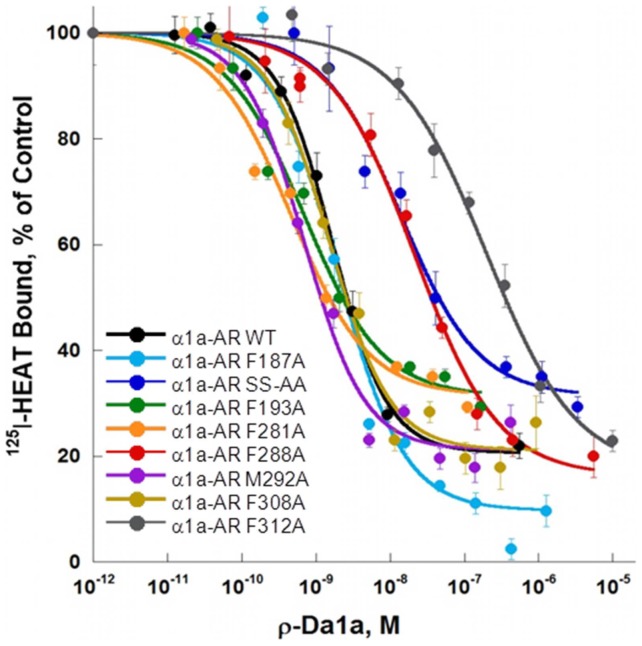
Receptor affinities for ρ-Da1a on mutated α1A-ARs.Binding inhibition curves for 125I-HEAT (200 pM) binding to WT (0.2 µg, black), F1875.41A (0.15 µg, light blue), the double S1885.42,S1925.46-AA (0.3 µg, dark blue), F1935.47A (0.25 µg, green), F2816.44A (0.15 µg, orange), F2886.51A (0.2 µg, red), M2926.55A (0.2 µg, purple), F3087.35A (0.1 µg, brown), F3127.39A (0.8 µg, grey), n = 3–4.